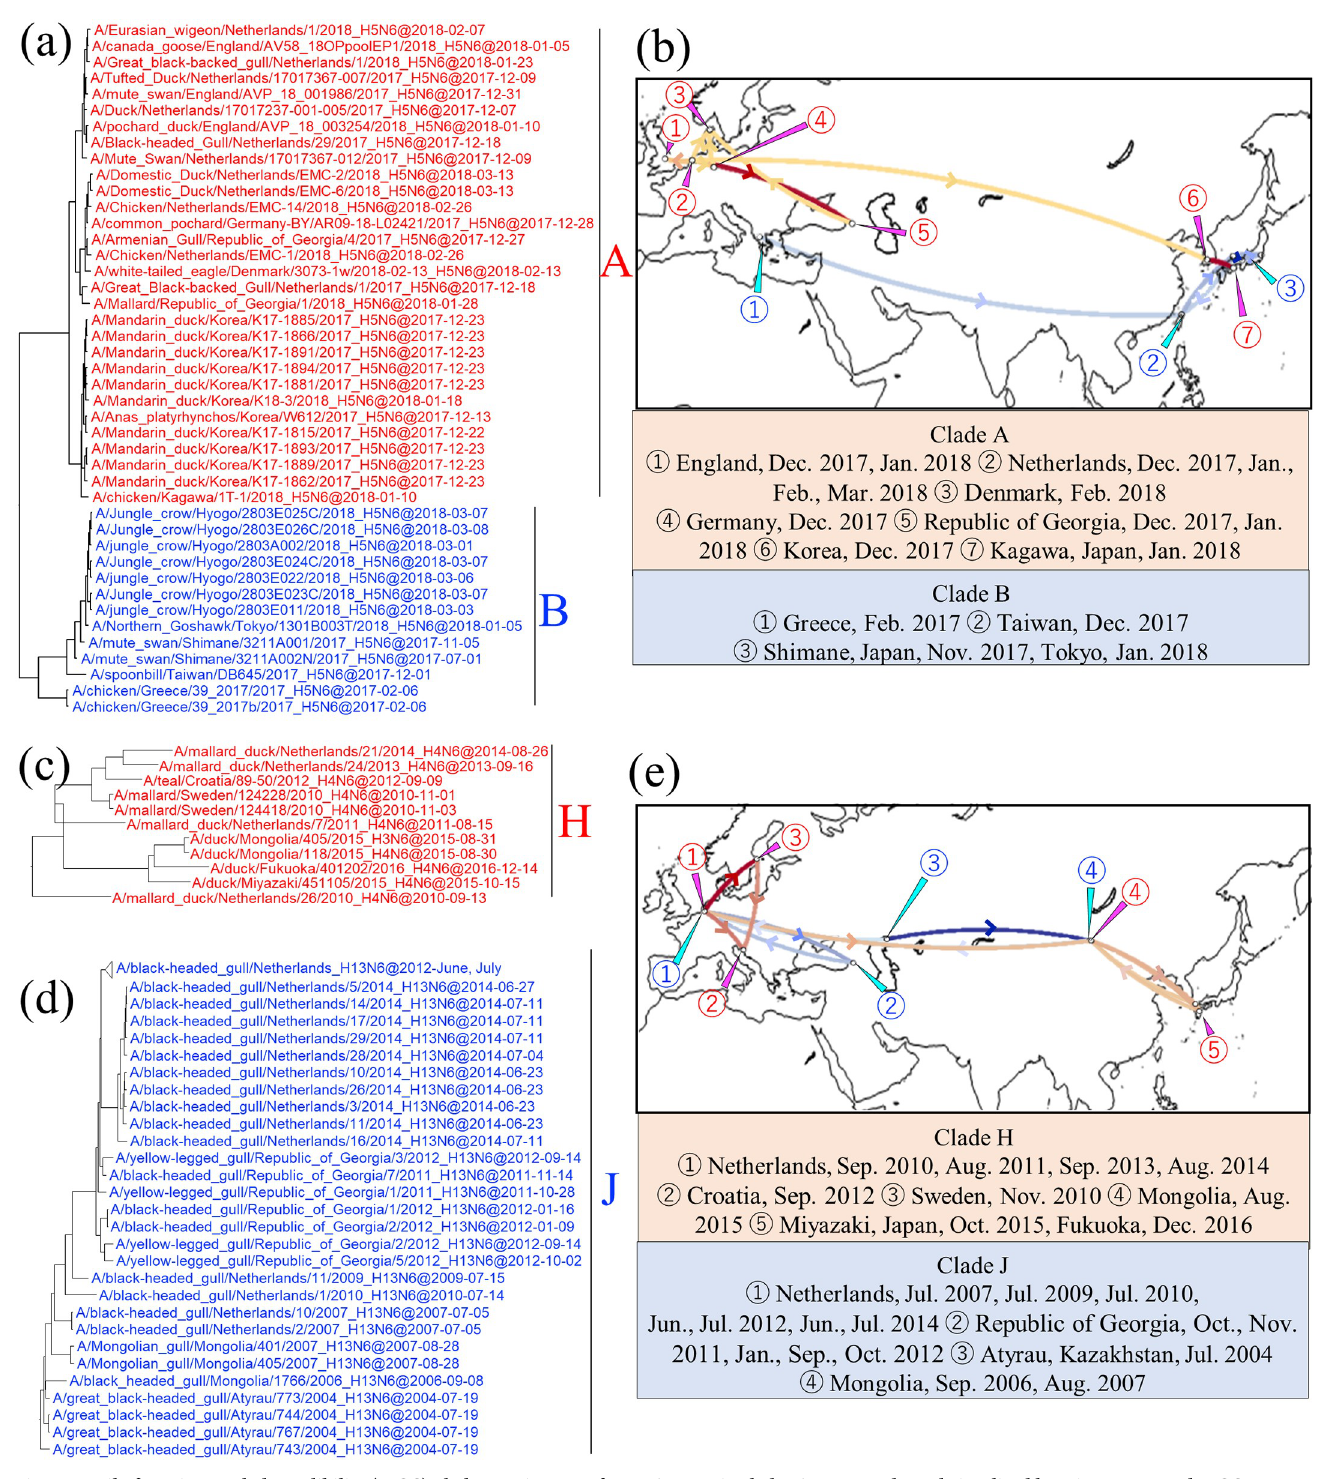
PLOS ONE | https://doi.org/10.1371/journal.pone.0218506 June 26, 2019 7 /